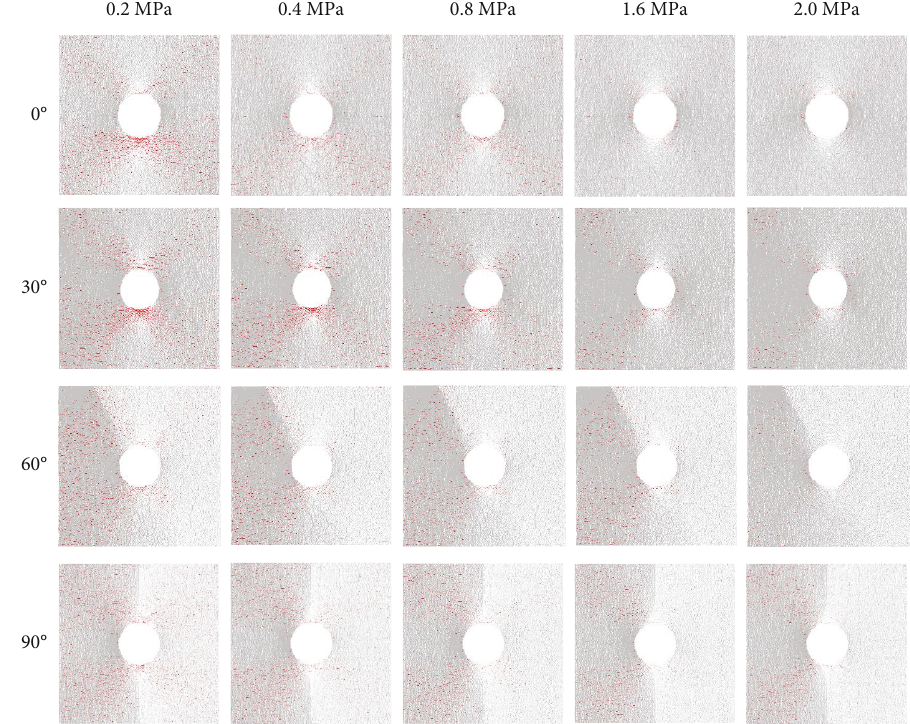
Figure 8: Distribution of contact force around the hole before crack initiation under di ff erent con fi ning